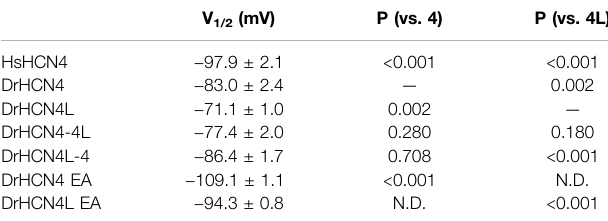
TABLE 2 | V 1/2 (mV) and p -values for the HCN4 channels. N.D.; not